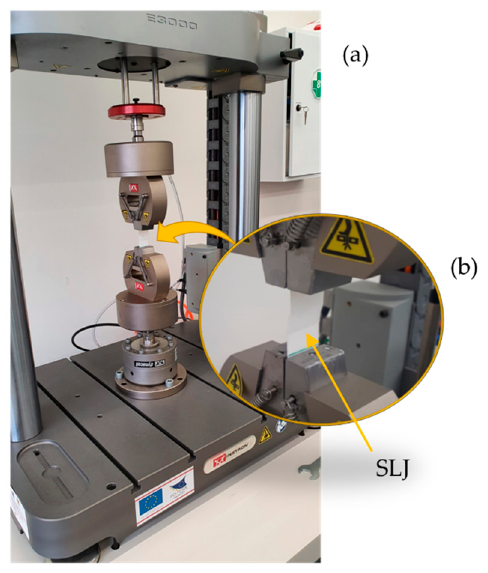
Figure 2. Experimental setup for fatigue tests ( a ). In the frame, the joint locked by the pneumatic grips is shown ( b ).